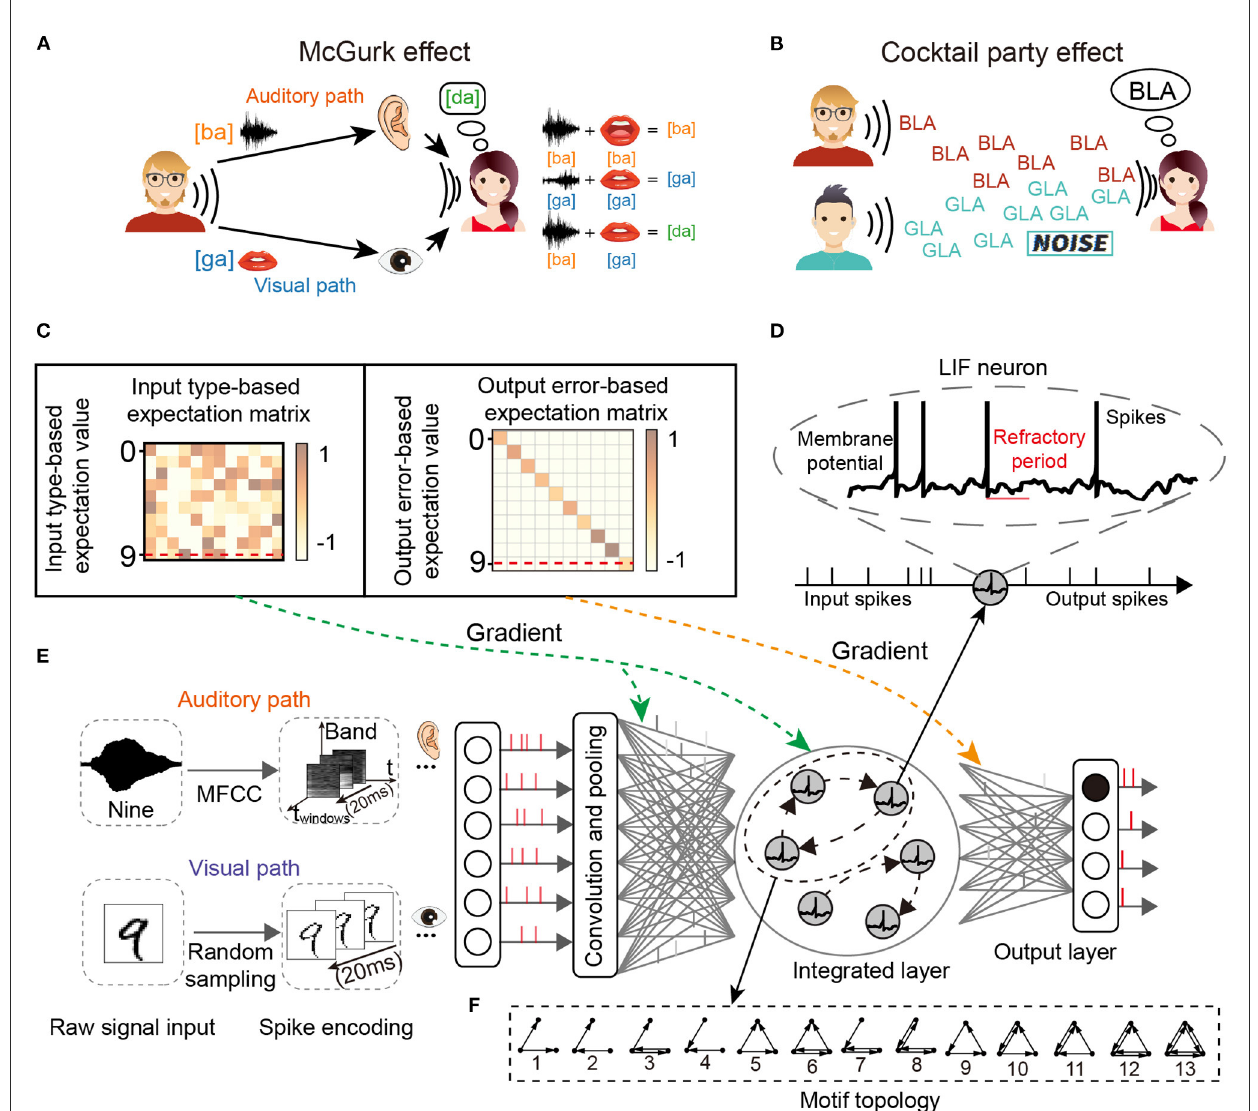
FIGURE1 The network structure for multi-sensory integration and two cognitive phenomena. (A) McGurk effect. New concepts arise when the receiver receives different audio-visual input information. (B) Cocktail party effect. When the receiver’s brain focuses on one speaker, it filters out the sounds and noise from others. (C) Input and output transformation matrix of reward learning. (D) The spiking neuron has a variable membrane potential. (E) The M-SNN network for single-sensory or multi-sensory integration tasks. (F) The example of 3-node Motifs.